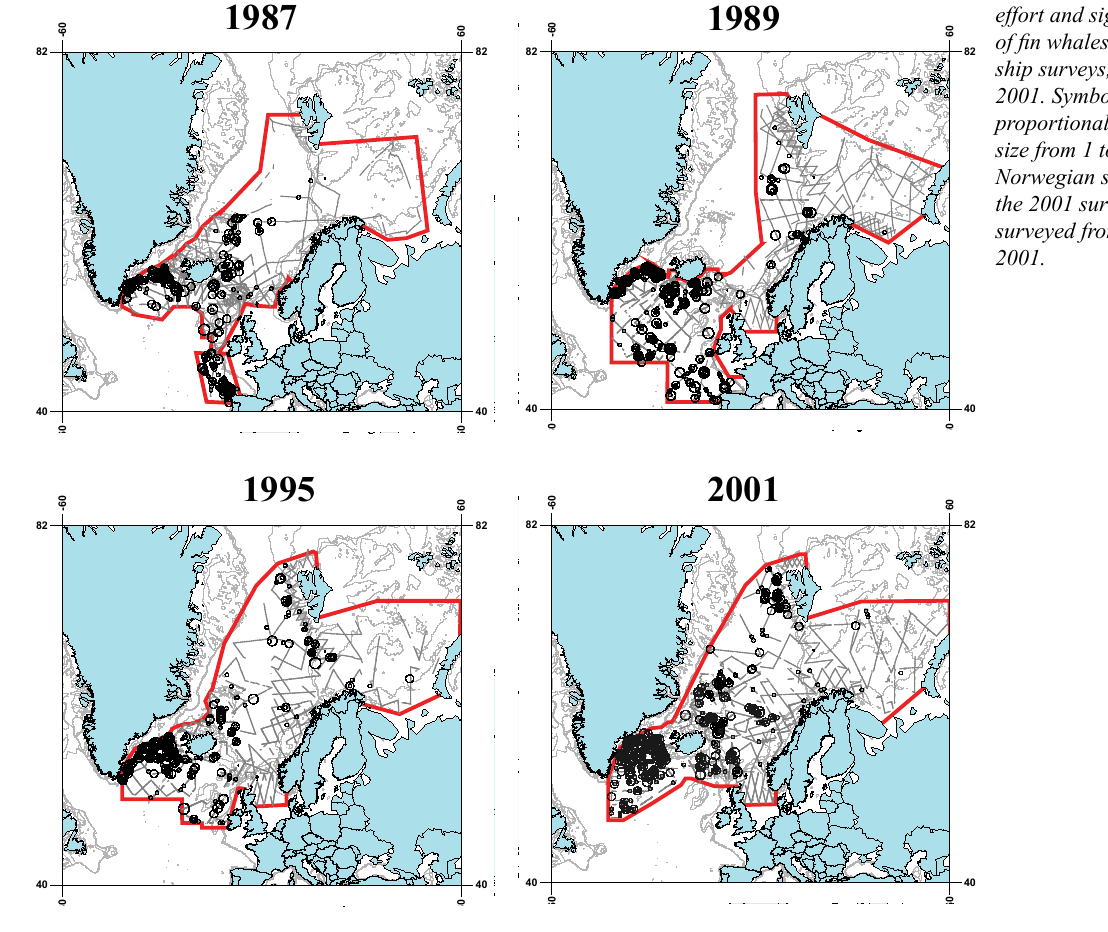
Fig. 4. Realized survey effort and sightings of fin whales in NASS ship surveys, 1987 to 2001. Symbol size